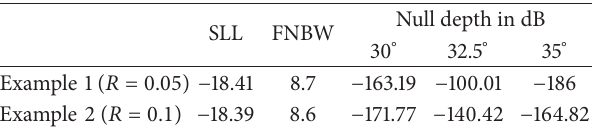
Table 2: Comparative results for 2𝑁 = 28 elements’ linear